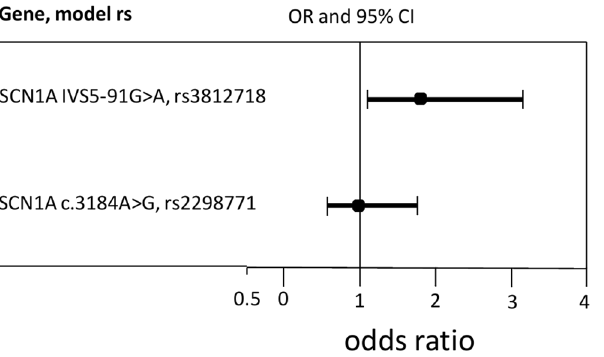
Fig 2. Graphical representation of adjusted odds ratio and 95% confidence intervals according to the SCN1A genes polymorphism; genotype and allele frequencies in epilepsy patients vs. healthy control subjects.